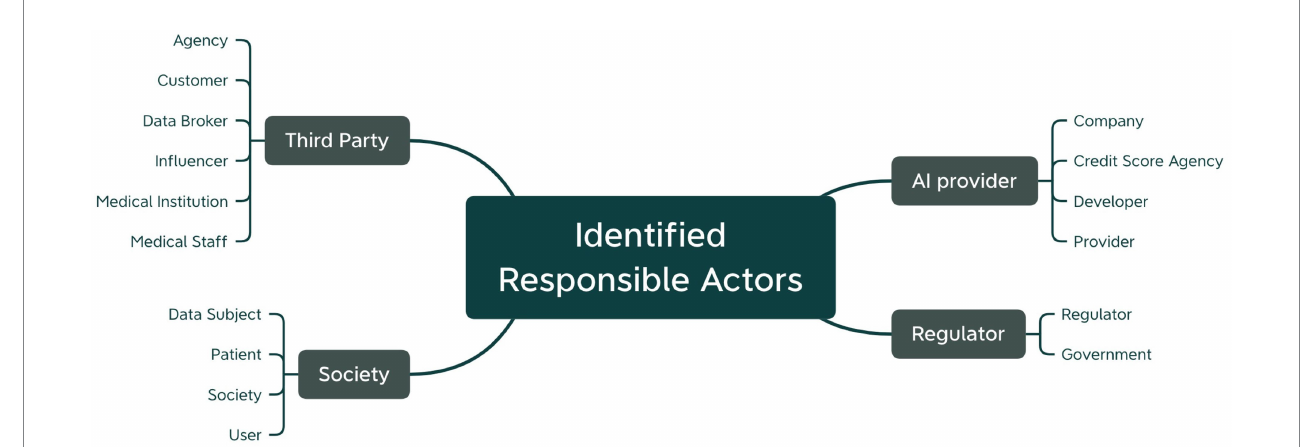
FIGURE 8 Responsibilities determined by the participants in the use case analysis exercise structured along the responsible